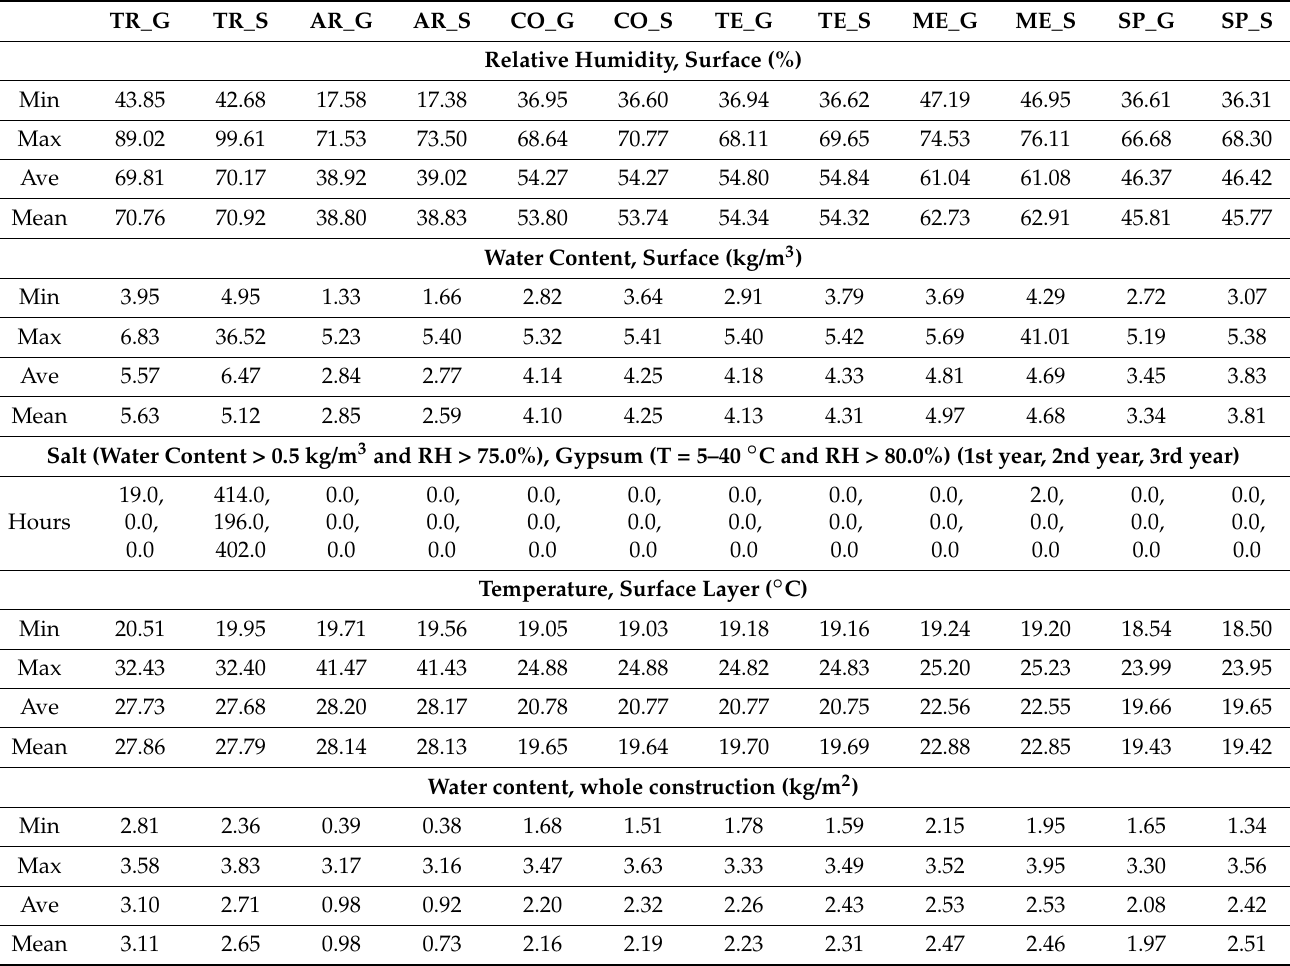
Table 5. The characteristics of the simulated relative humidity, temperature, and water content in gypsum/salt and the water content in the whole exterior wall in different climate conditions: the minimum, the maximum, the average, and the mean